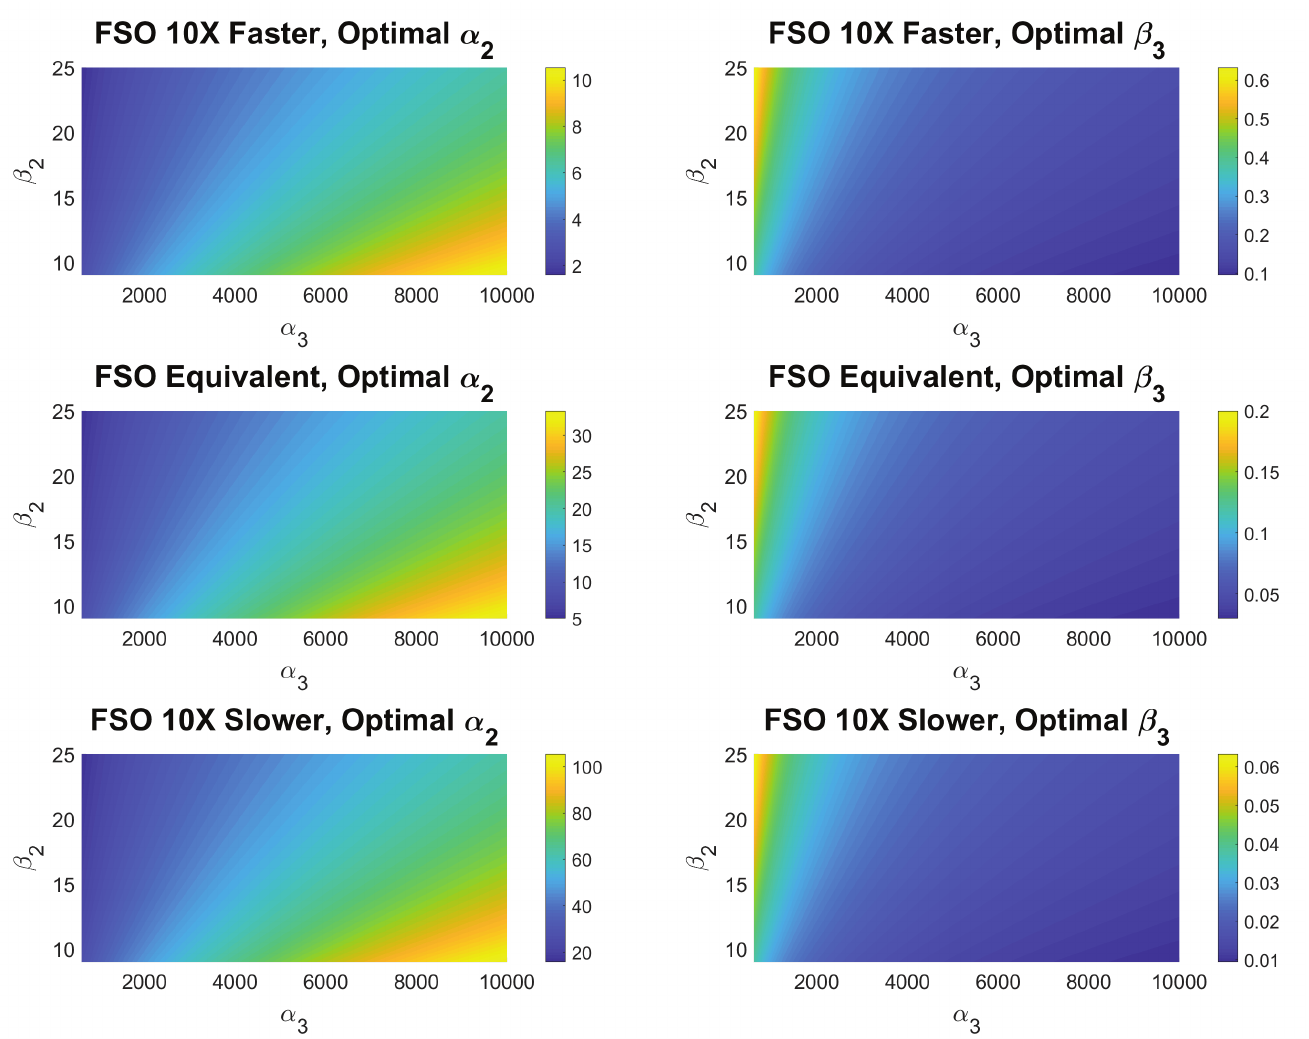
Figure 8. Optimal Tier 2 resolution (i.e., α 2 ) and Tier 3 range (i.e., β 3 ) for systems where relative switching times are related by: t 2 / t 3 = 10 ( top ); t 2 = t 3 ( middle ); and t 2 / t 3 = 0.1 ( bottom